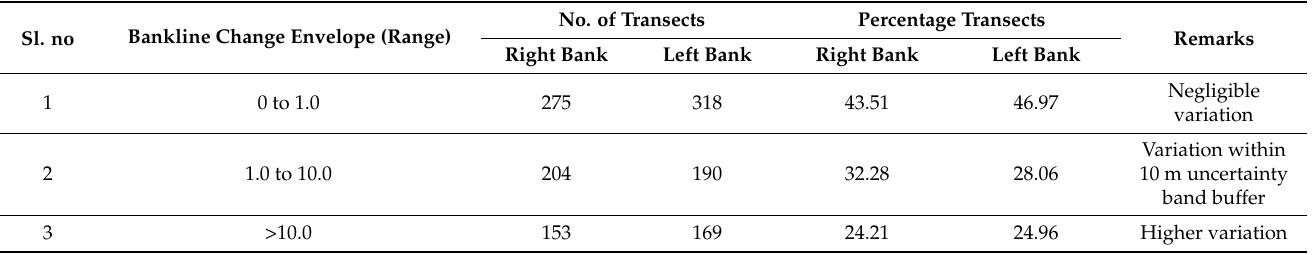
Table 7. BCE for the validation of the predicted